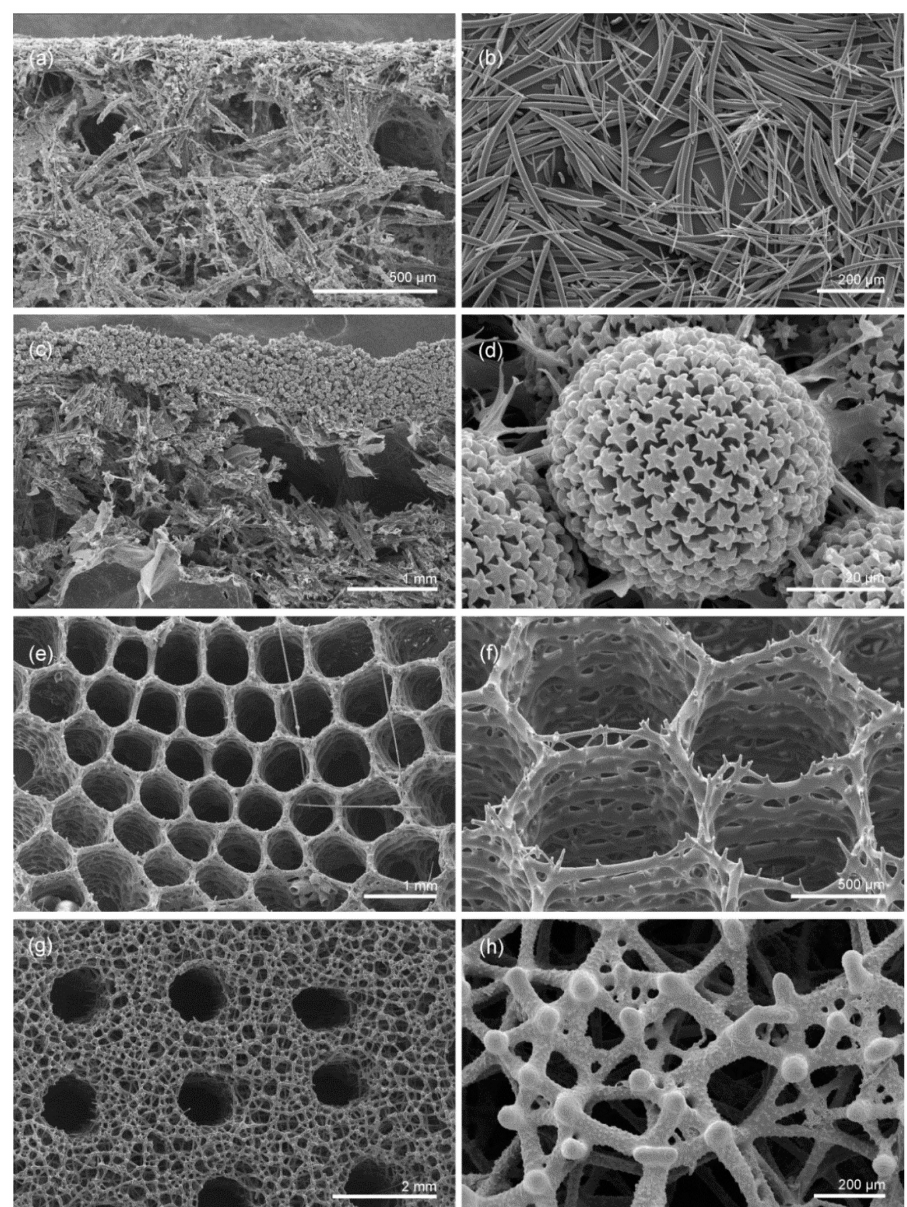
Figure 1. Scanning electron microscopy (SEM) images of the four samples investigated in this study. ( a , b ) Petrosid demosponge PETRO: ( a ) untreated, scale bar = 500 µ m, ( b ) after organics removal, scale bar = 200 µ m; ( c , d ) Geodia sp demosponge GEODIA: ( c ) untreated, scale bar = 1 mm, ( d ) untreated, scale bar = 20 µ m; ( e , f ) Aphrocallistes sp. hexactinellid sponge APHRO: ( e ) untreated, scale bar = 1 mm, ( f ) after organics removal, scale bar = 500 µ m; ( g , h ) Laocoetis perion hexactinellid LAOCO: ( g ) after organics removal, scale bar = 2 mm, ( h ) after organics removal, scale bar = 200 µ